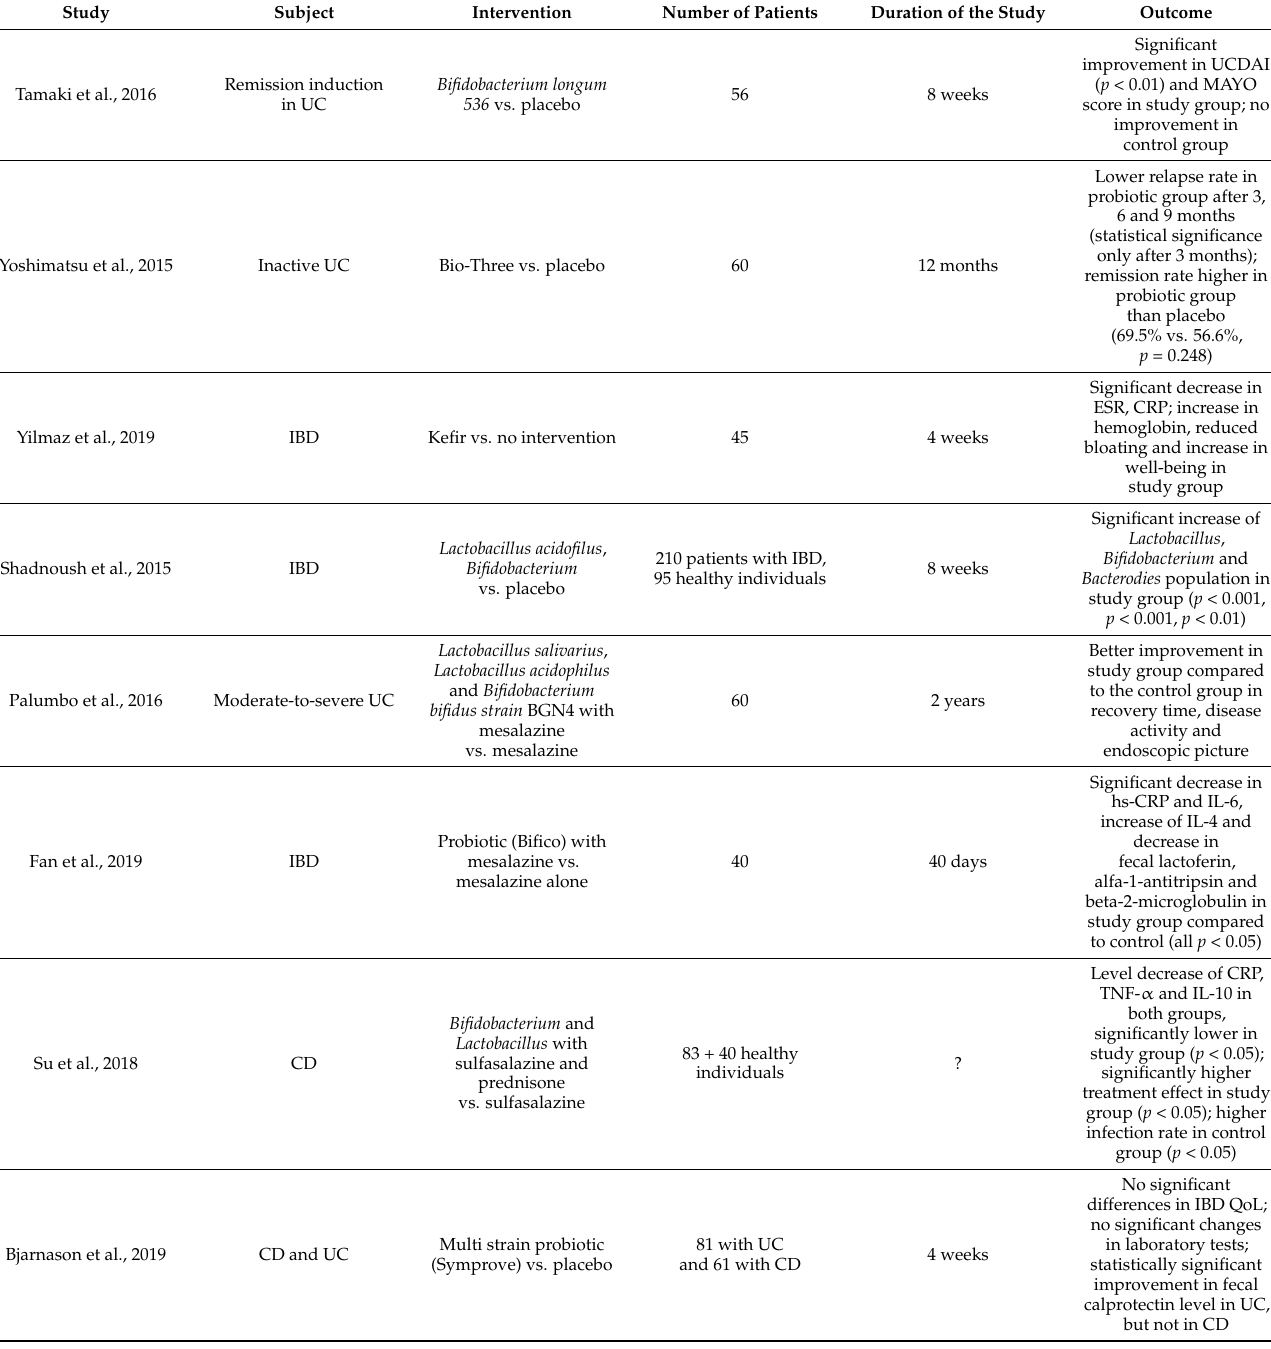
Table 2. Studies evaluating probiotics in IBD